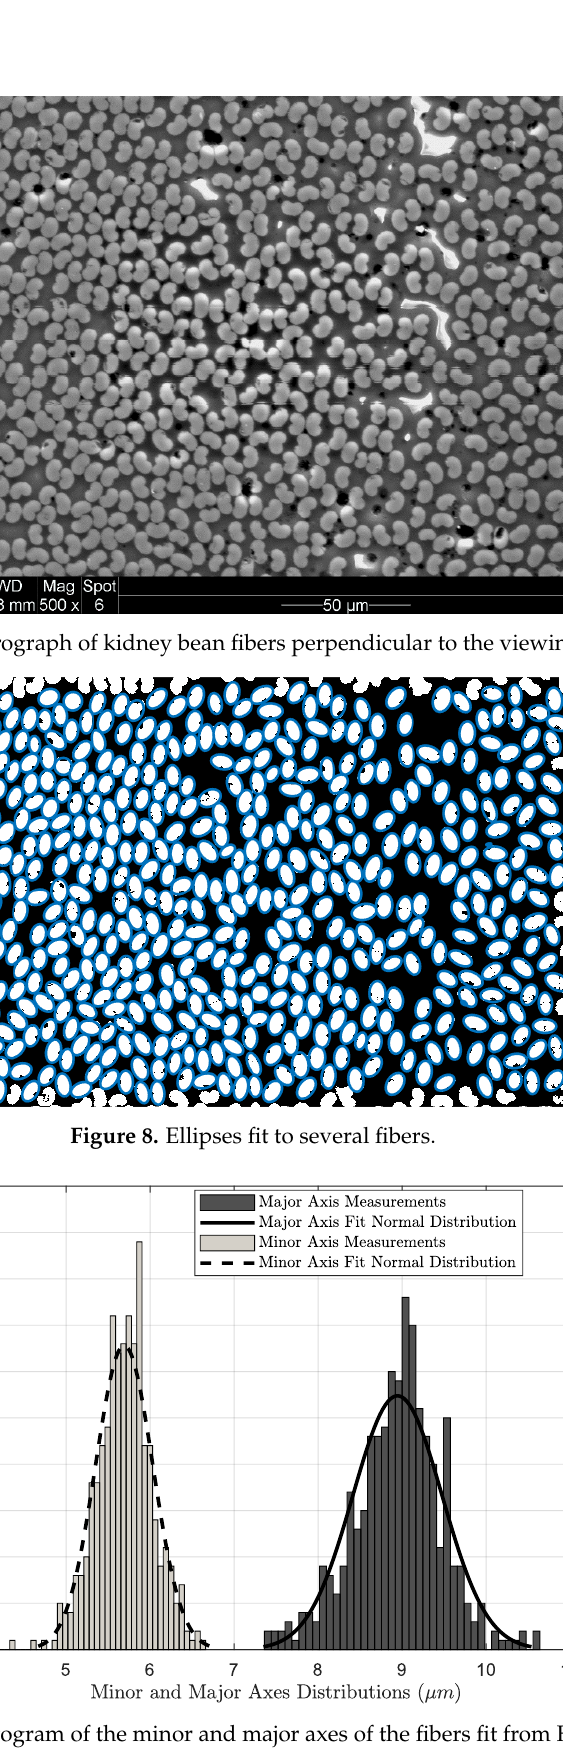
Figure 9. Histogram of the minor and major axes of the fibers fit from Figure